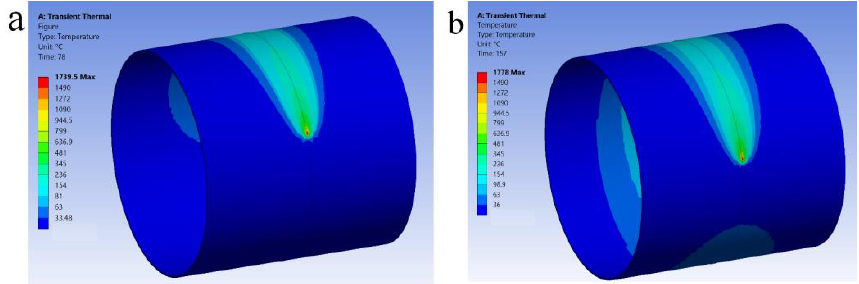
Fig. 8. Temperature profile during circumferential welding at different time frames.